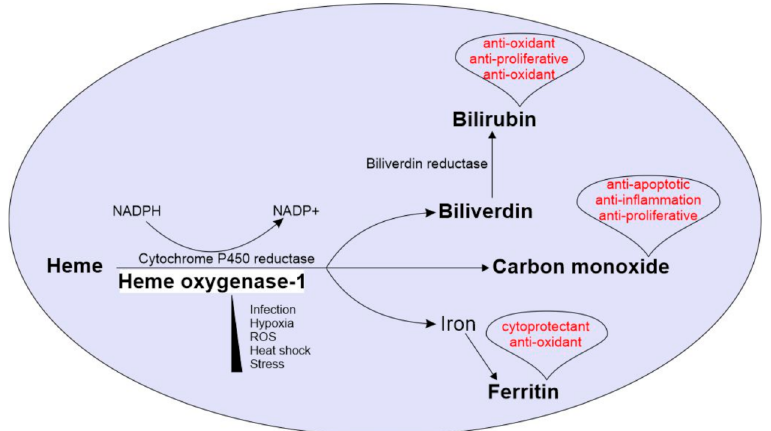
Figure 1. Overview of Heme oxygenase-1 (HO-1) enzymatic reaction and physiological roles of its enzymatic by-products: HO-1 is induced under various physiological challenges including stress, hypoxia, ROS, heat shock and microbial infections. The HO-1 catabolizes heme into equimolar ratios of CO, iron and biliverdin, using NADPH and cytochrome p450 reductase. Biliverdin is further converted into bilirubin by biliverdin reductase. The free iron is stored by the iron storage enzyme ferritin. CO, bilirubin and ferritin drives several host protective physiological roles including anti-inflammation, cryoprotection and anti-oxidation. Physiological roles of each by-product are in red